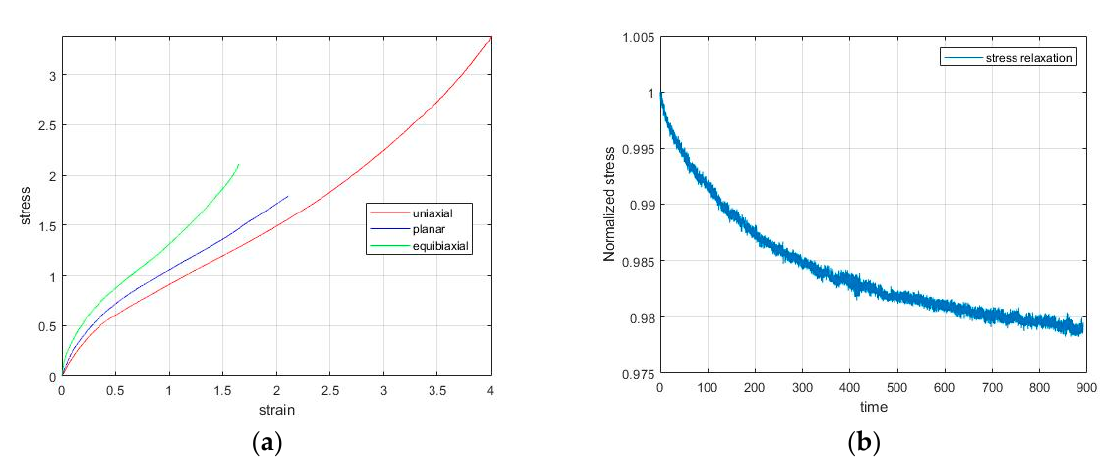
Figure 2. Experimental data of ( a ) uniaxial, planar, equibiaxial tests until fracture, ( b ) stress relaxation beginning from 100% strain.